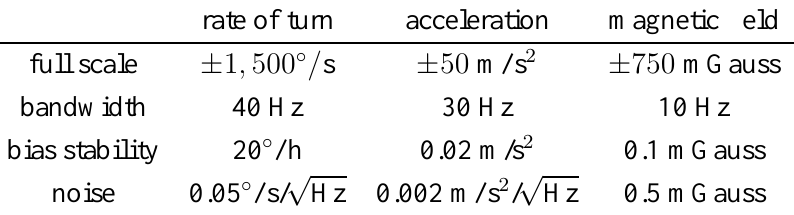
Table 1. Specifications of XSens MTi28A53G25.